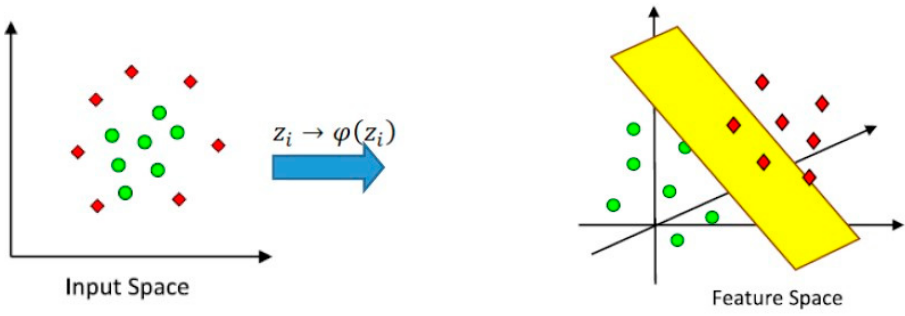
Figure 4. Transforming input features from a lower dimension to a higher dimension.